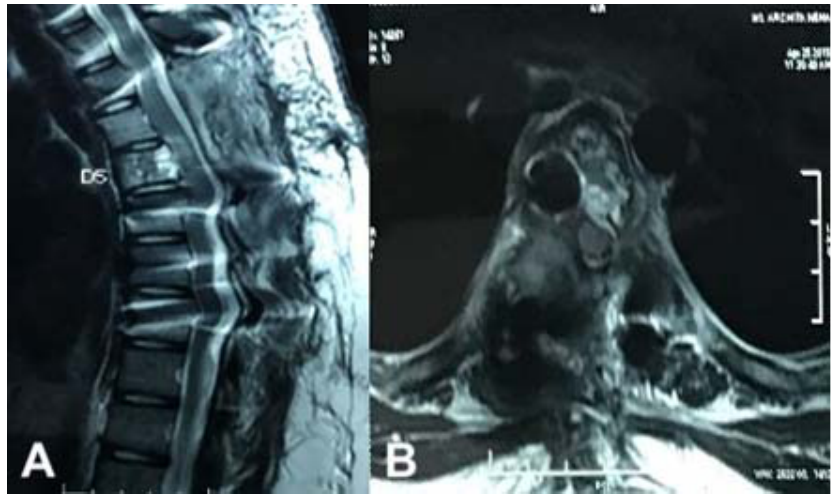
Figure 3. Post second intra-lesional resection MRI showing removal of epidural compressive mass. Dorsal spinal cord decompressed ventro- dorsally on sagittal (A) and axial views (B) No evidence of enhancing fl uid fi lled lesion on T2WI of MRI.